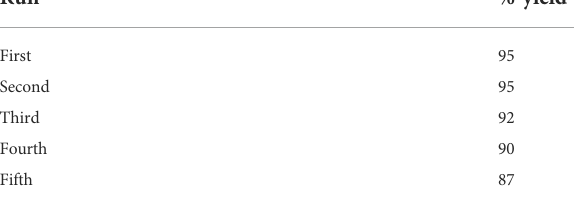
TABLE 3 How often the catalyst is reused for the synthesis of compound